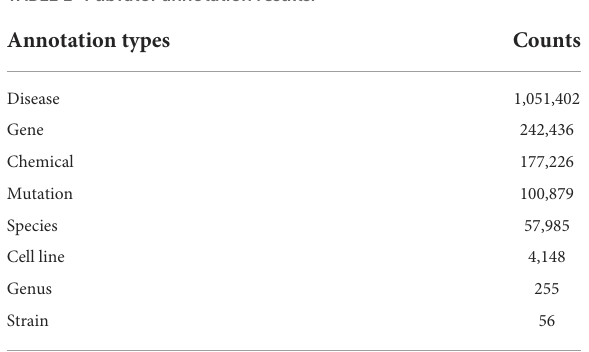
TABLE 1 PubTator annotation